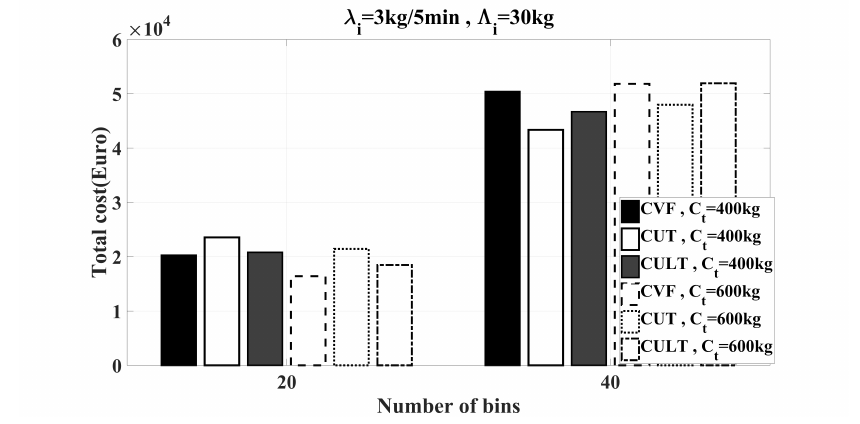
Figure 8. Cost: bin count when the bin capacity was increased.